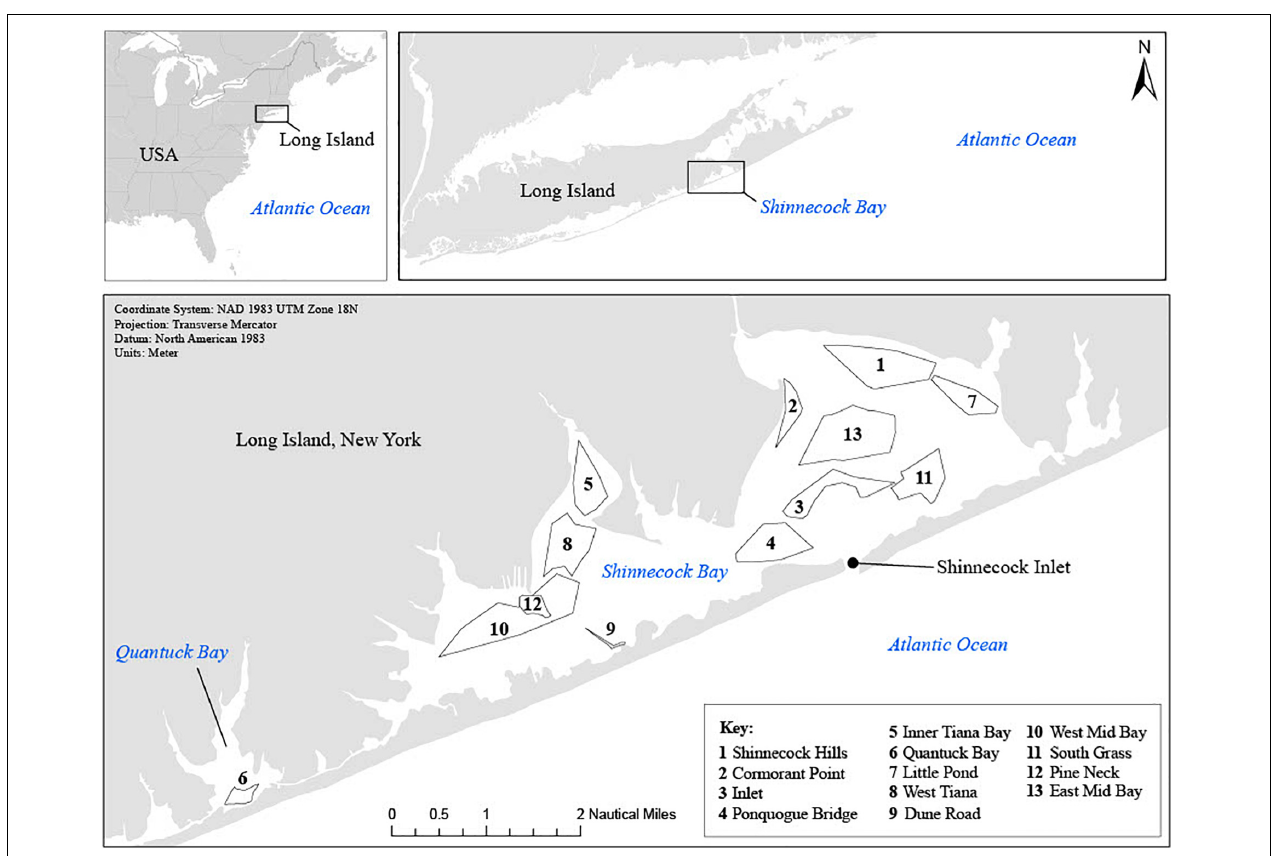
FIGURE 1 | Map of Shinnecock Bay with station areas, station numbers and station IDs, for the sampling seasons of 2014, 2015, and 2016. Data source: ESRI, HERE, Garmin© OpenStreetMap contributors, GIS user community. Map credit: Maria